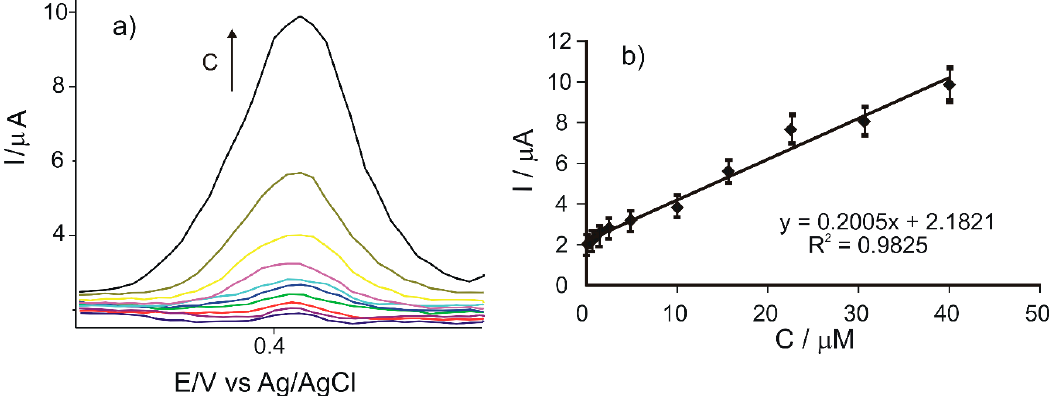
Figure 5. ( a ) Zoomed-in view of the anodic peak zone of the cyclic voltammograms registered with CNF / C-SPE immersed in ca ff eic acid solutions with the concentrations in the 0.1–40 µ M range. ( b ) Linear dependence between the anodic peak current and the concentration of the ca ff eic acid solution.